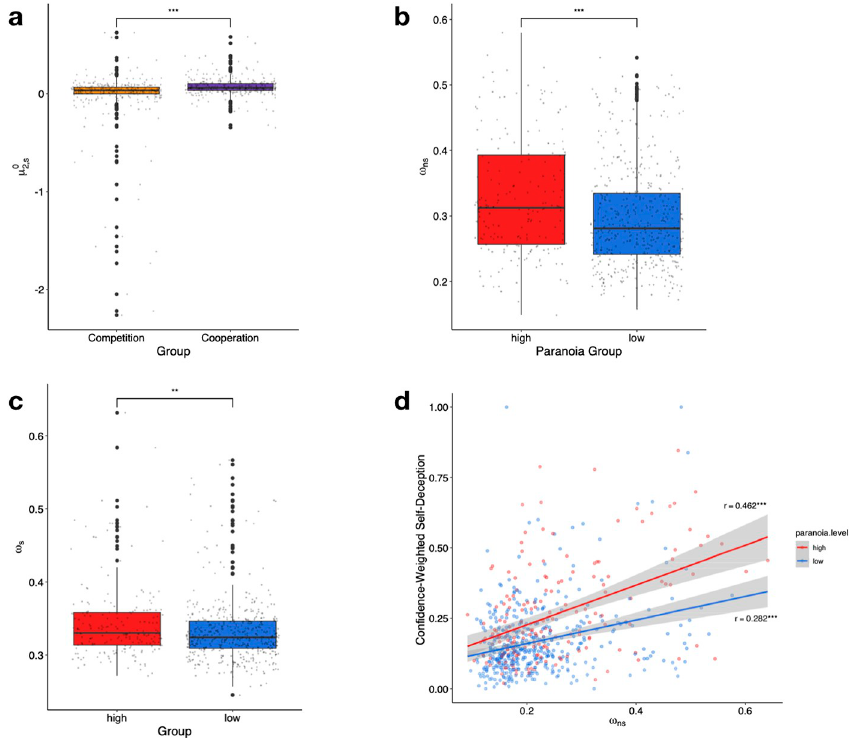
Fig 4. Estimated parameters show differences based on paranoia group and experimental group. A , the cooperation group has an elevated prior for the social information ( μ 0 2,s ) compared to the competition group. B , the variance of the perceived tendency of image categorization ( ω ns ) is increased in high paranoia group as well as C , the variance of the perceived tendency of bet accuracy ( ω s ). � P � 0.05, �� P � 0.01, ��� P � 0.001. D , ω ns (variance of x s,ns ) is correlated with confidence weighted self-deception. The correlation is statistically stronger in the high paranoia group. � P � 0.05, �� P � 0.01, ��� P � 0.001.